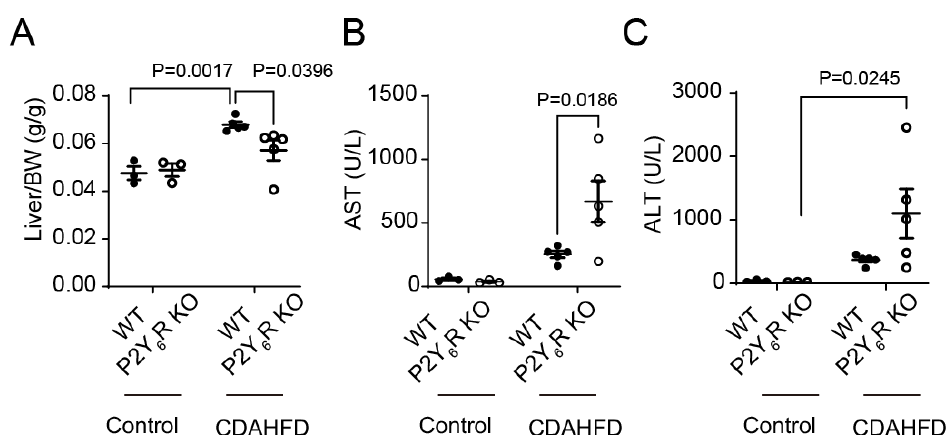
Figure 3. Liver weights and serum levels of AST and ALT in WT and P2Y 6 R KO mice fed with CDAHFD. ( A ) Liver weights. ( B , C ) Comparison of serum levels of AST ( B ) and ALT ( C ) among P2Y 6 R KO and WT mice. Data are shown as the mean ± SEM (control WT: n = 3, control P2Y 6 R KO: n = 3, CDAHFD WT: n = 5, CDAHFD P2Y 6 R KO: n = 5). Two-way ANOVA followed Sidak ’ s multiple comparison test.